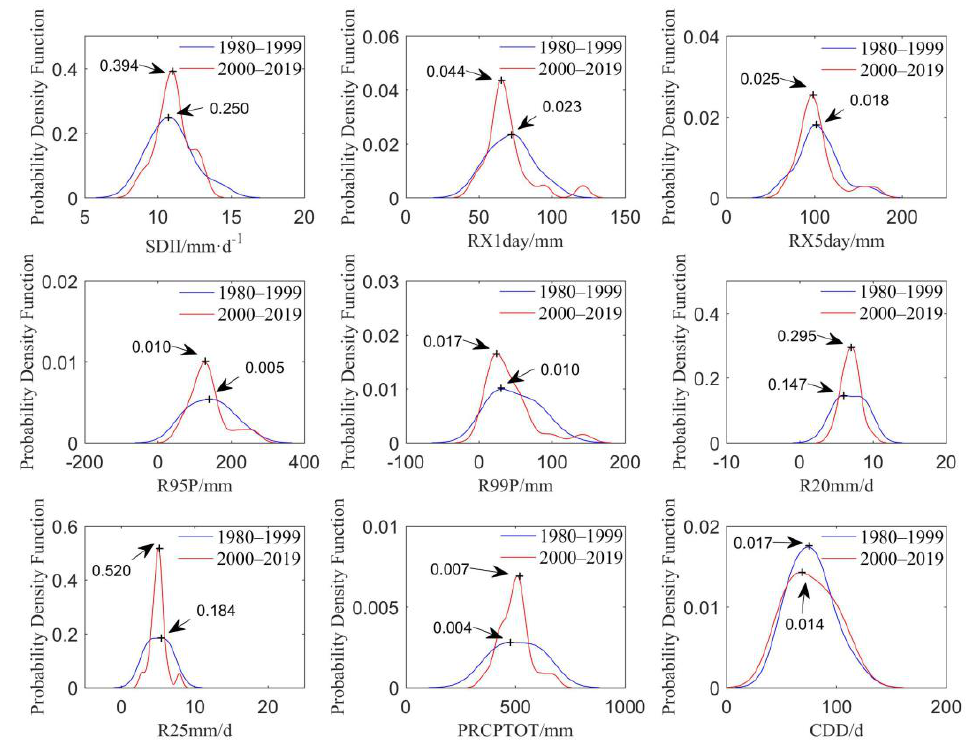
the pdf distribution of TNn, TX10P, TN10P, and DTR differed significantly in the two periods. Figure 6. Probability density functions for Beijing–Tianjin–Hebei extreme precipitation indices from Figure 6. Probability density functions for Beijing – Tianjin – Hebei extreme precipitation indices from 1980 to 2019 for two time periods: 1980 – 1999, and 2000 – 2019.